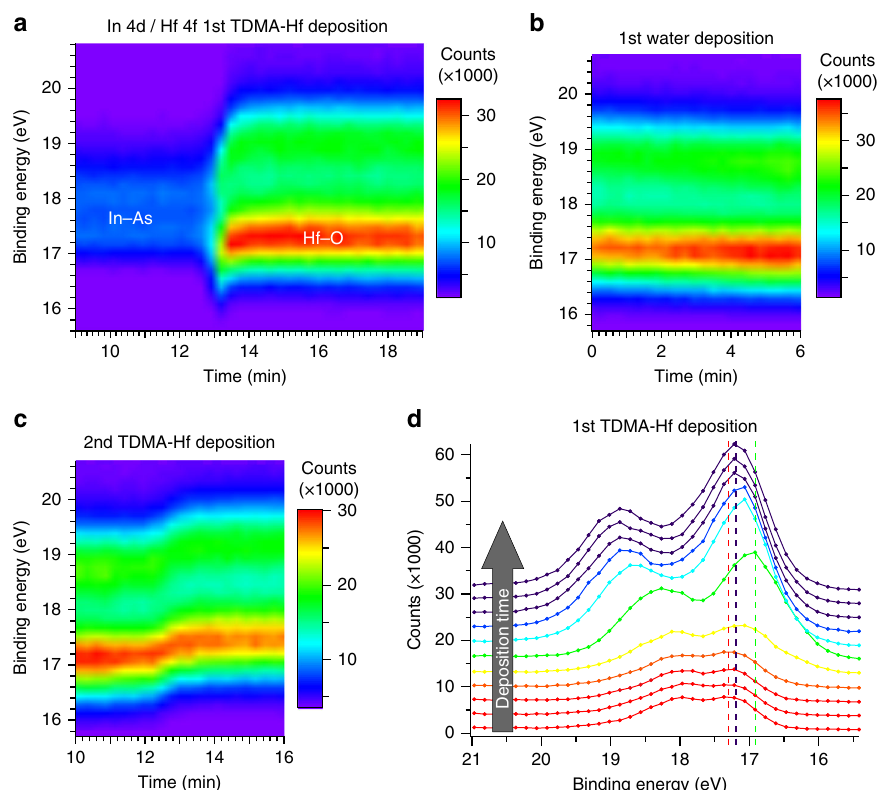
Fig. 2 Time-resolved Hf surface chemistry. Time evolution of Hf 4f and In 4d core level XP spectra, which are overlapping in binding energy, during the initial half-cycles of the ALD reaction, i.e., fi rst deposition of TDMA-Hf ( a ), fi rst deposition of water ( b ), and second deposition of TDMA-Hf ( c ). During the fi rst half-cycle ( a ), fi rst only a weak signal corresponding to In – As and In-oxide components can be seen, until the reaction sets in. Afterward, the spectra are dominated by the Hf signal, because the photoionization cross-section for Hf 4f is seven times larger than that for In 4d (at the photon energy of 300 eV used here) 37 . At the onset of the Hf 4f peak, a signi fi cantly lower binding energy is observed only for a few seconds during the initial phase of the reaction. d Subsequent In 4d/Hf 4f XP spectra of the time evolution series shown in a shortly before (red), during (orange, yellow, green, cyan, blue), and after (dark purple) this initial phase of Hf incorporation. Peak binding energies of some distinct spectra are indicated by dashed lines (in corresponding colors). The time delay between individual spectra was 16 s. The timescales correspond to the opening of the gas inlet valve. Spectra were obtained at a photon energy of 300 eV, a gas pressure of about 0.3 Pa, and a sample temperature of 220